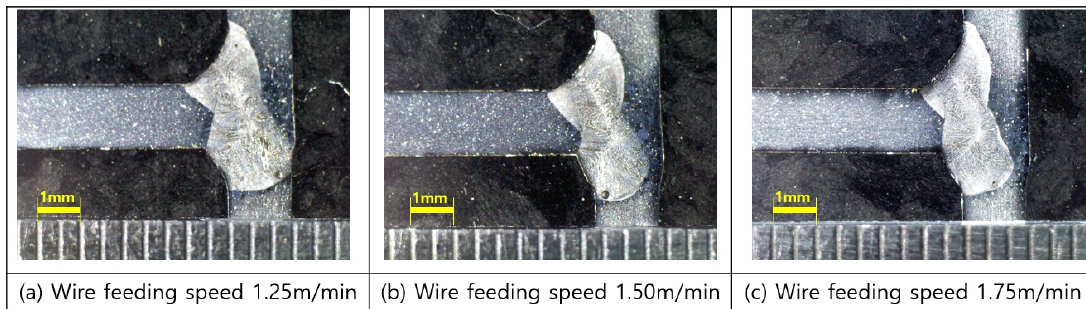
Figure 8. Different wire feeding speeds with 1.75 kW of laser power.